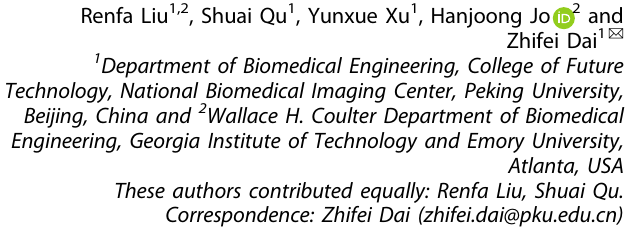
Fig. 1 Spatial control of transgene expression in mouse artery with ultrasound. a The mouse carotid artery can be localized by color Doppler ultrasound imaging. By changing the size and position of color box, the ultrasound image can be zoomed to the area of interest so that ultrasound was focused to this area. After MBs injection, the MBs can be destroyed, as evidenced by the color “ blooming ” phenomenon. b AAV gene vector carrying the expression cassette for EGFP. ITR, internal terminal repeats; CAG, a hybrid construct consisting of the cytomegalovirus (CMV) enhancer fused to the chicken beta-actin promoter. c Illustration of UMGAAV protocol. After MB injection, ultrasound irradiation was applied to the area of interest for 30 s. Following AAV injection, the mouse was sacri fi ced at speci fi c time points for qPCR analysis using 18S as an internal control. d Representative 3-D view of confocal assessment of EGFP expression in LCA and RCA. EGFP was immunostained with EGFP antibody (red). The DAPI staining marks cell nuclei (blue). The green auto fl uorescence was from the internal elastic lamina (IEL). e Transgene expression of EGFP in endothelial cells (ECs) and medial and adventitial layer (M + A) of LCA and RCA at different time points post AAV injection. The time interval between MB and AAV injection was ~5 min. f Quanti fi cation of AAV fl uorescence in LCA and RCA. Fluorescently-labeled AAV was injected after ultrasound treatment in LCA and the mice were sacri fi ced at 1 h and 3 h post injection. The AAV fl uorescence in the arteries were quanti fi ed. g Representative image of mouse suprarenal abdominal aorta (SAA) and infrarenal abdominal aorta (IAA) with color Doppler imaging. h Transgene expression of EGFP in SAA and IAA when SAA or IAA was treated with ultrasound. i The mouse femoral artery can be detected with contrast-enhanced ultrasound imaging. After focusing the ultrasound to the major branch of femoral artery, the MBs can be selectively destroyed with color Doppler ultrasound imaging. j Transgene expression of EGFP in mouse femoral artery when right femoral artery (RFA) was treated while the left femoral artery (LFA) was untreated. k Expression of KLK10 in arterial endothelium in mice with different treatments. Saline, mice were injected with saline only; US&MB only, LCA were treated with ultrasound after MB injection; AAV9-EGFP + US&MB, the mice were injected with AAV9 expressing EGFP after ultrasound treatment; AAV9- KLK10 only, the mice were injected with AAV9-KLK10 without ultrasound treatment; AAV9-KLK10 + US&MB, the mice were injected with AAV9- KLK10 after ultrasound treatment. l En face VCAM1 staining of carotid artery. The arteries were immunostained with VCAM1 antibody (red). The DAPI staining marks cell nuclei (blue). The green auto fl uorescence was from IEL. m Representative bright- fi eld images of aortic trees (top lane) and the Oil-Red-O staining (middle lane) and anti-CD45 immunostaining (bottom lane) of frozen sections prepared from the